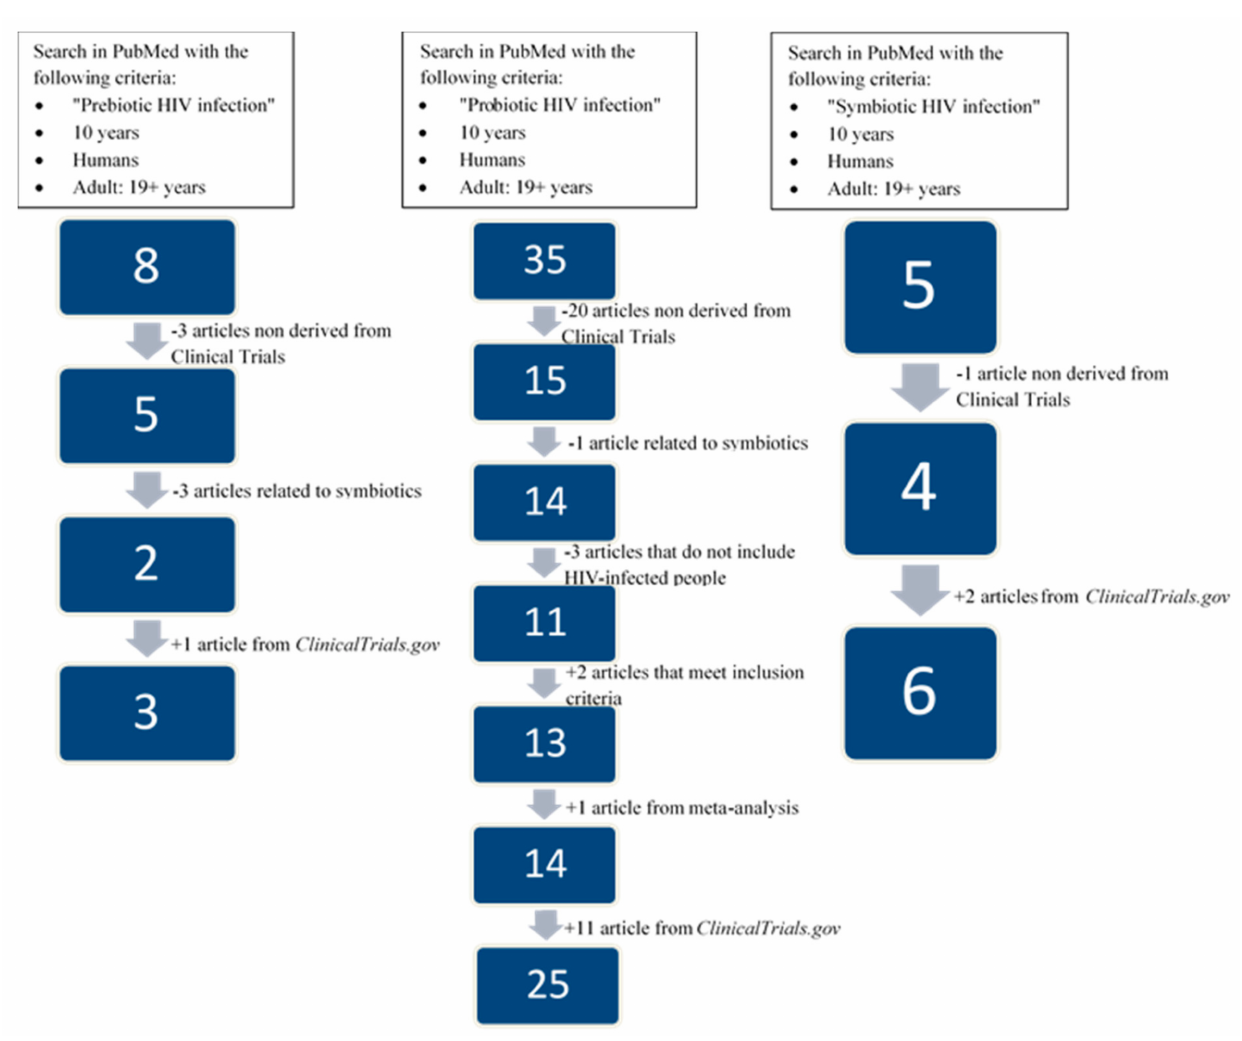
Figure 2. Flow chart of the study selection concerning the effects of prebiotics, probiotics, and symbiotics in HIV-infected